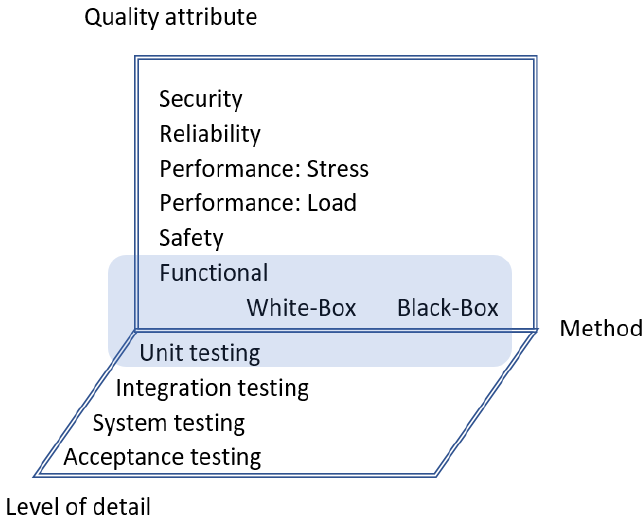
Fig. 2. Dimensions of software testing